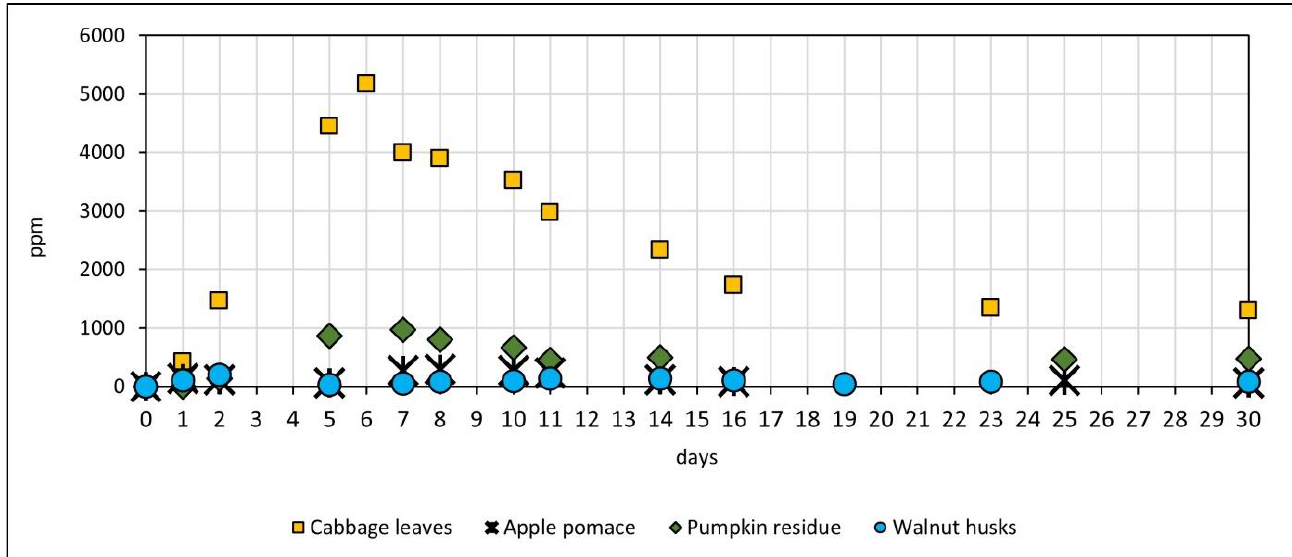
Figure 5. Concentration of hydrogen sulphide in biogas produced from four fruit and vegetable residues.